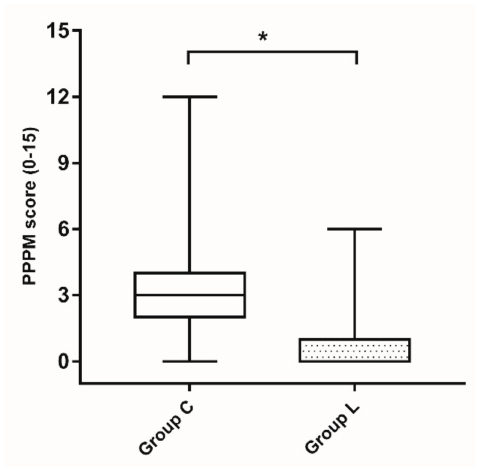
Figure 3. Post-operative pain measurement (PPPM) scores completed by the parents 24 h after discharge. Boxes represent the interquartile range; black bars in boxes represent the median. The ends of vertical lines indicate the minimum and maximum data values. * p <